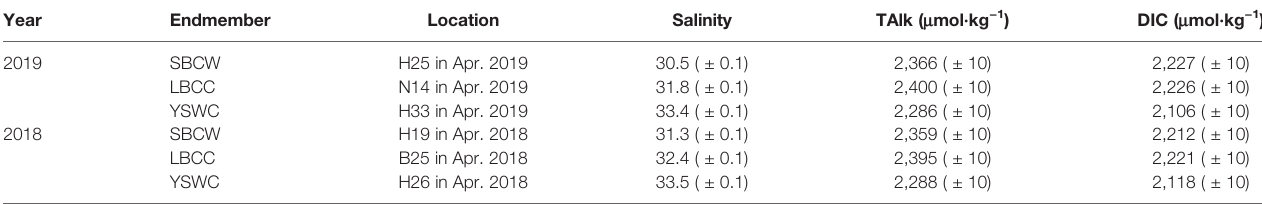
TABLE 2 | Endmember values and their